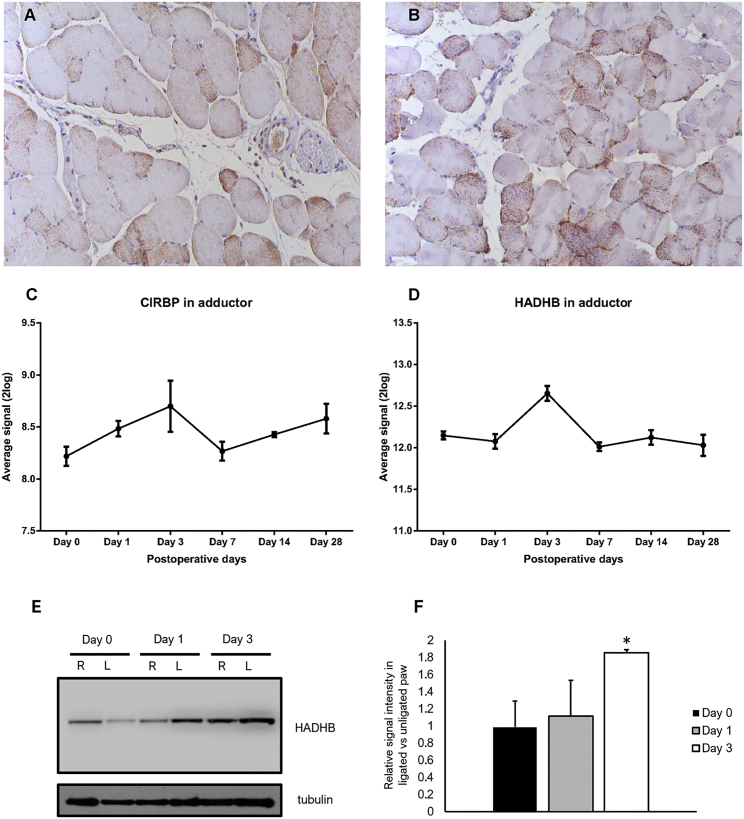
Expression of CIRBP and HADHB In Vivo(A and B) Immunohistochemical staining of murine adductor muscle after ischemia induction revealed expression of both CIRBP (A) and HADHB (B) in these tissues, predominantly in the cytoplasm of cells. (C and D) Microarray analysis of mRNA expression of CIRBP (C) and HADHB (D) mRNA in the adductor muscle of mice at several time points after induction of ischemia (4 mice per time point). (E) Western blot showing HADHB levels in murine adductor muscle tissue on day 0, day 1, and day 3 after hindlimb ligation. For each time point, samples from right (R) unligated paws and left (L) ligated paws are presented next to each other. Tubulin was used as a loading control. (F) Quantification of the western blot. The HADHB signal was normalized against tubulin, and the relative change between ligated and unligated is presented. Each bar represents a biological triplicate and technical duplicate.